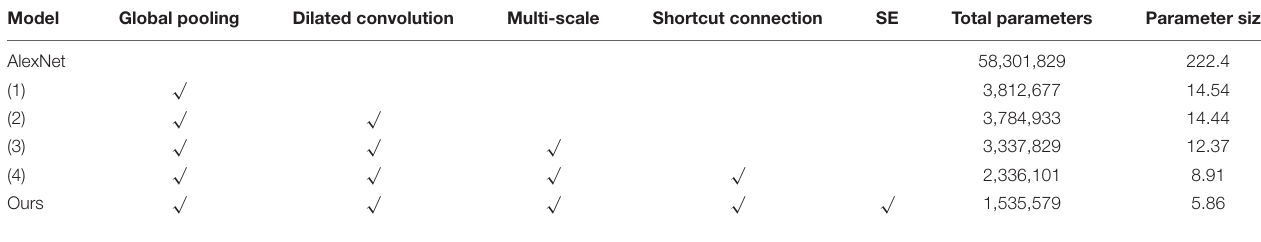
TABLE 4 | Comparison of the parameters of each module: (1) add global pooling, (2) add dilated convolution, (3) add multi-scale convolution, and (4) use shortcut